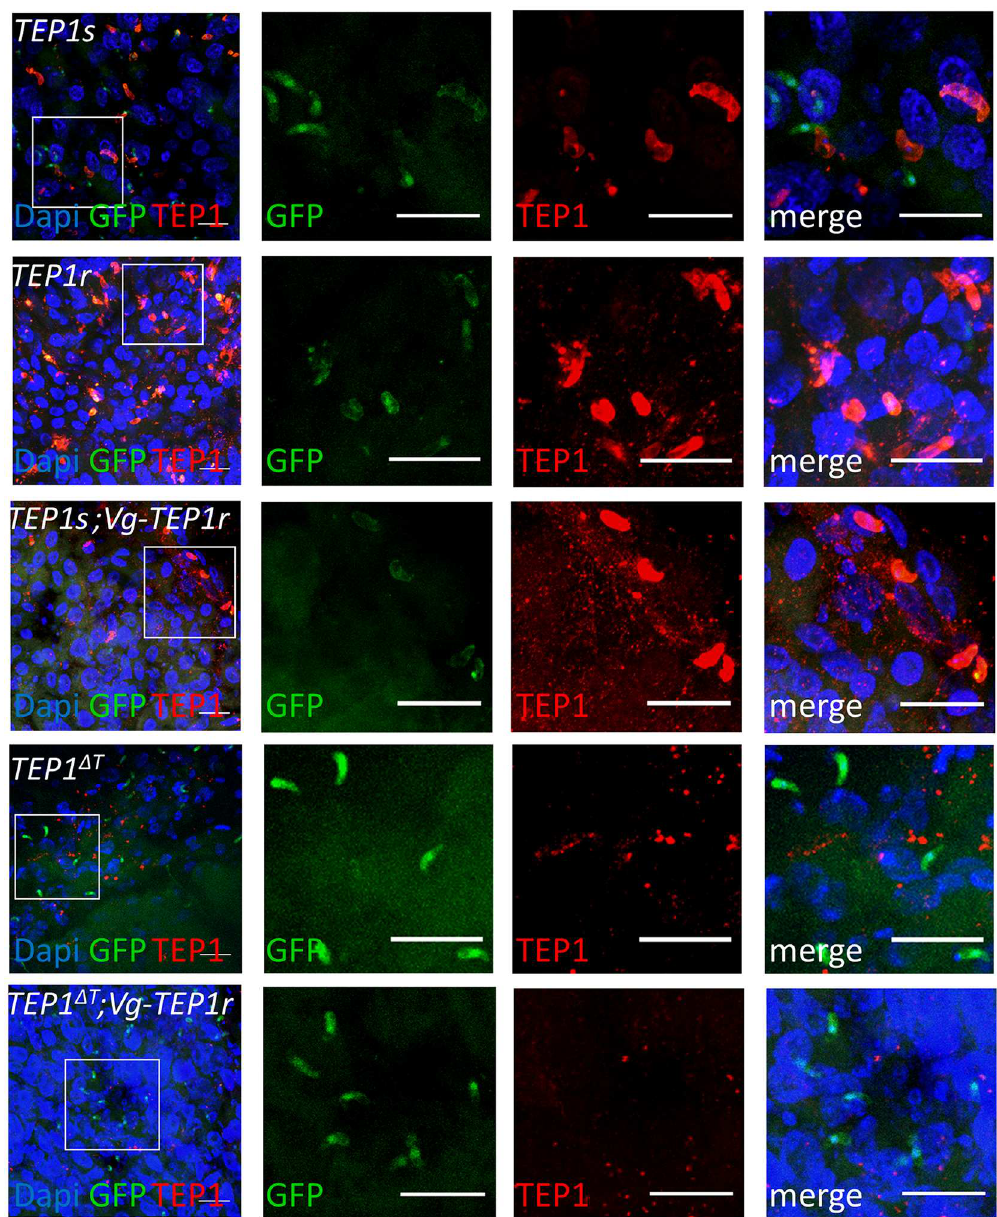
Fig 5. Binding of transgenically expressedTEP1 to ookinetes. TEP1 antibody staining(red) of dissected midguts 24 h after infection with GFP-expressing P . berghei .Shownare wild type mosquitoes expressingthe TEP1s allele (TEP1s) , wild type L3-5 mosquitoes expressingthe TEP1r allele( TEP1r ), mosquitoestransgenically expressing TEP1r in a wild type TEP1s background ( TEP1s;Vg-TEP1r ), mutant TEP1 mosquitoes( TEP1 Δ T ), and mutant mosquitoestransgenically expressing TEP1r ( TEP1 Δ T ;Vg-TEP1r ). Ookinetes express GFP (green)and nucleiare stained with Dapi (blue). Images are stacks of confocalz-sections, scale bar = 20 μ